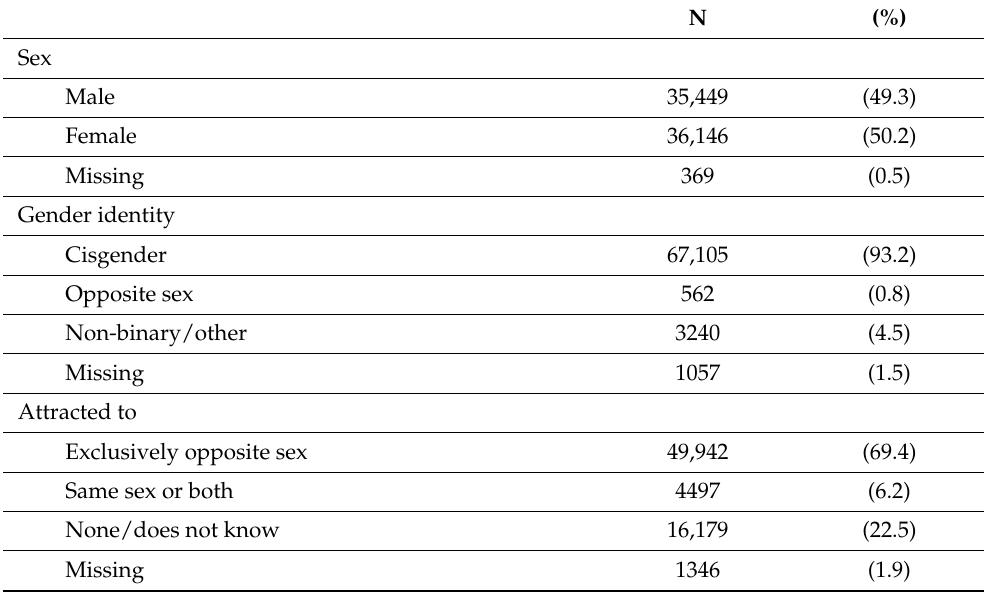
Table 1. Distributions of sex, gender and sexuality related variables and sociodemographic back- grounds and mean age in years among eighth and ninth graders of comprehensive schools participat- ing in the School Health Promotion Survey in Finland in